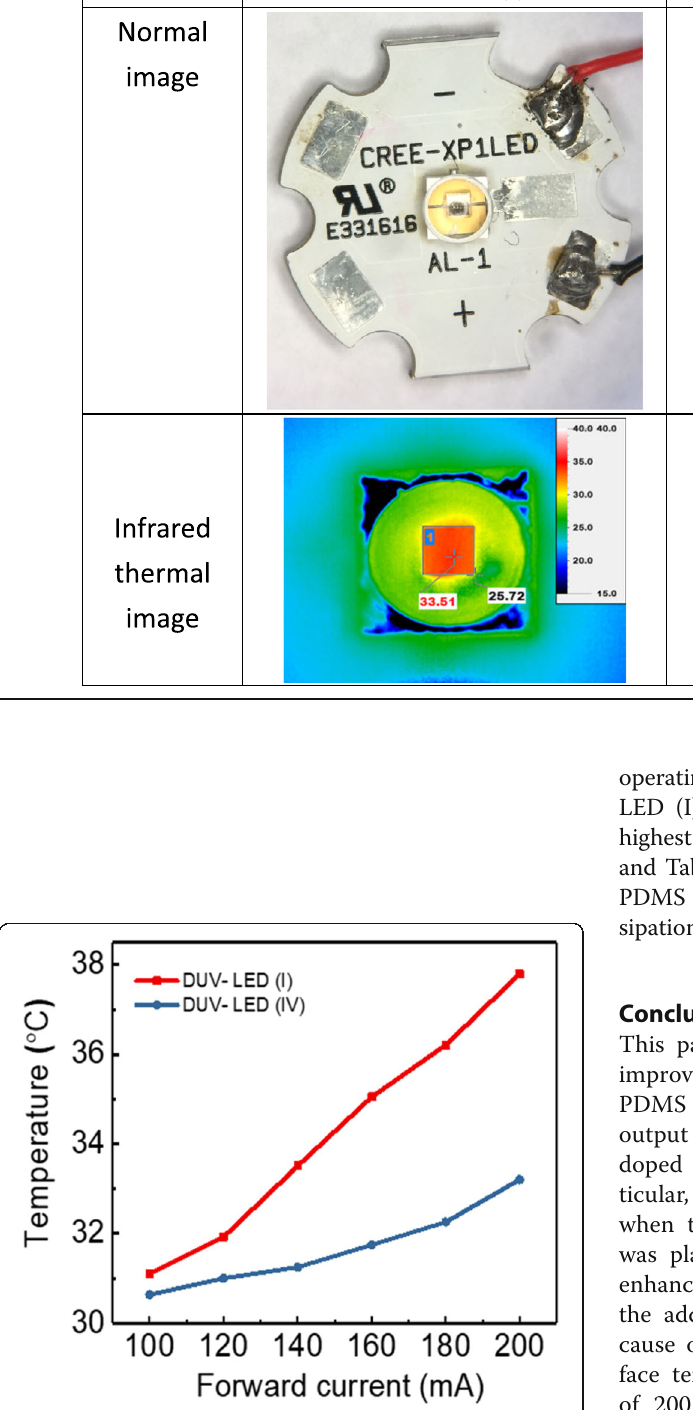
Fig. 4 Average surface temperature dependence of DUV-LED (I) and DUV-LED